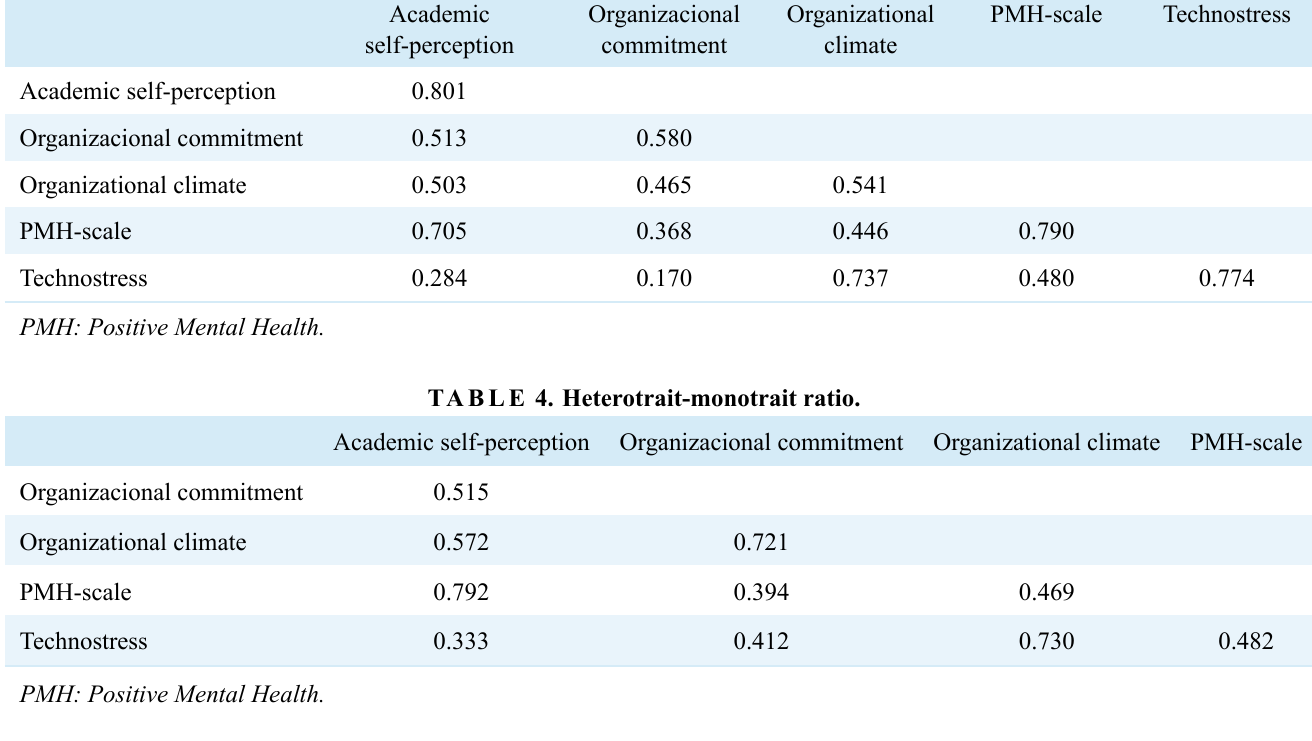
TABLE 5. probability